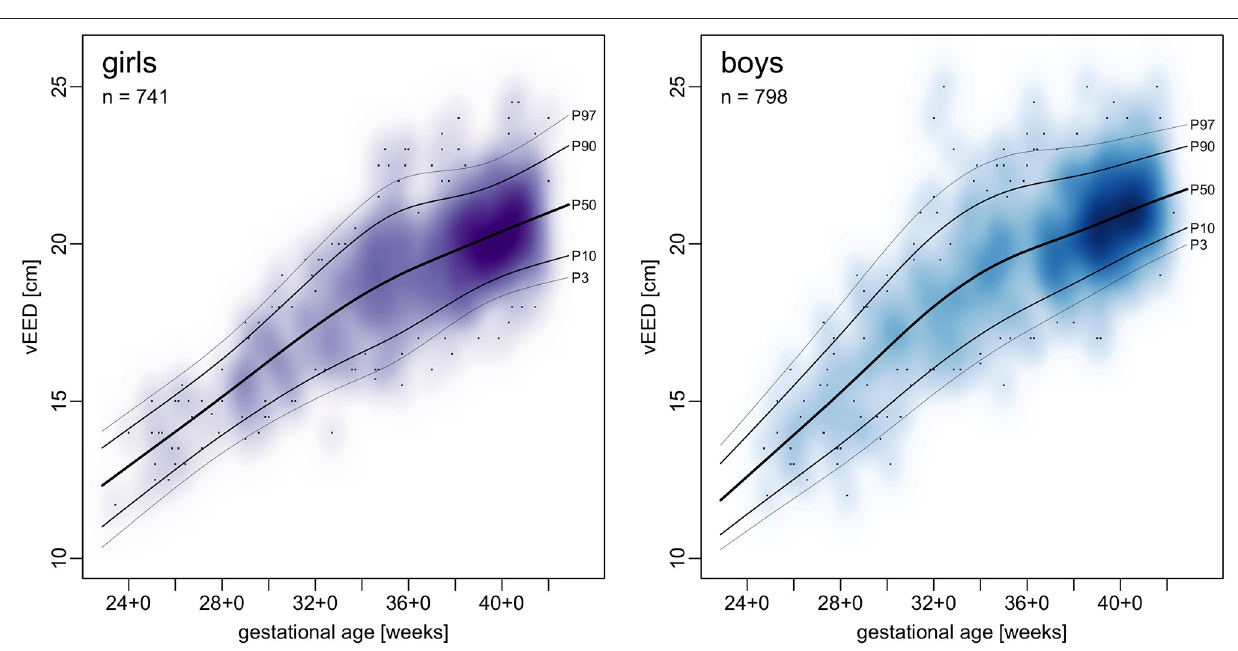
FIGURE 3 | Charts of transvertical ear-to-ear distance (vEED) in relation to gestational